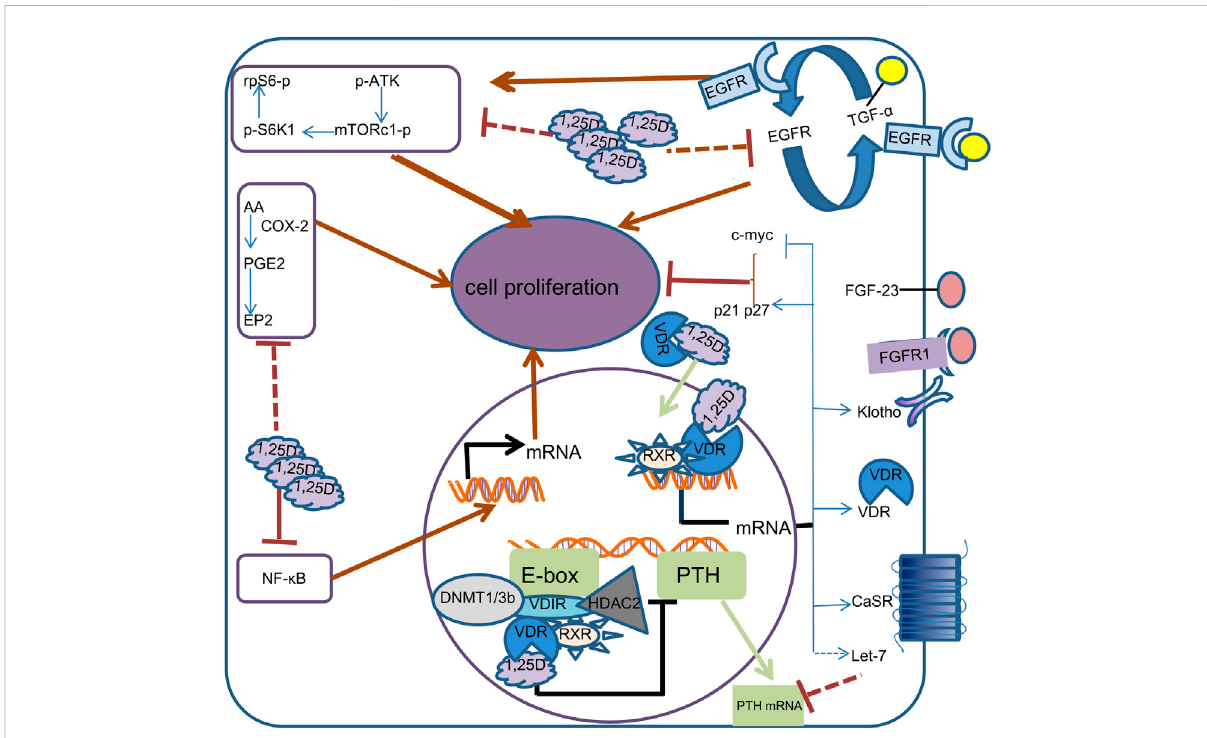
FIGURE 1 Mechanism of calcitriol in parathyroid cells. In the cell, 1,25D binds to VDR, which is translocated to the nucleus.1, 25D-bound VDR can form different complexes in different promoter regions. By binding to RXR and VDIR, it recruits histone deacetylases HDAC2 and DNA methyltransferases DNMT1 and DNMT3b to inhibit transcription of the PTH gene, thereby reducing the synthesis and secretion of PTH. 1, 25D-bound VDR induces transcription of calcium-sensing receptor (CaSR), Klotho, VDR, Let-7, c-myc, CDKN1a and CDKN1b genes by directly binding RXR to vitamin D response elements on DNA. Increased CaSR expression leads to higher sensitivity of parathyroid cells to calcium, while increased Klotho transcriptionresultsinincreasedsensitivitytoFGF23.c-myc,p21andp27supresscellproliferationbyinhibitingcellcycleprogression.Theincreased transcription of Let-7 family decreased the stability of PTH mRNA. 1,25D also represses the proliferation of Parathyroid cells by reducing epidermal growth factor receptor (EGFR), Nuclear factor-KB (NF-kB), mTOR complex 1(mTORc1) and prostaglandin E2(PGE2) signaling